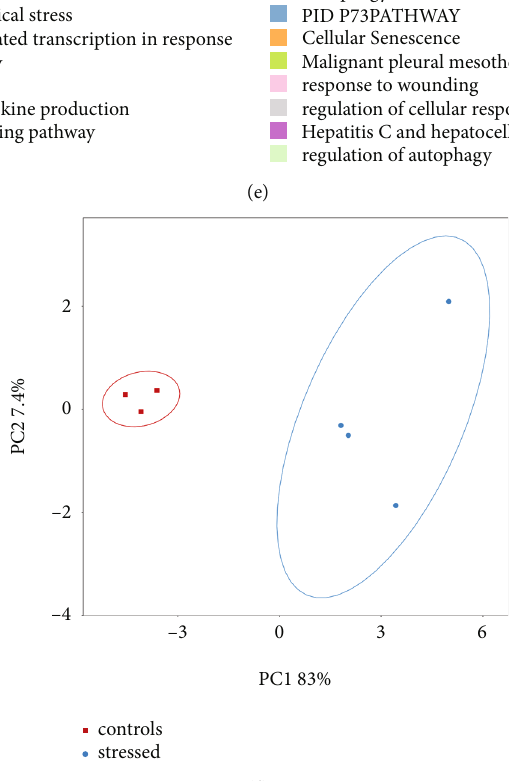
Figure 3: Core-DEGs screening, function, and pathway enrichment analysis. (a) PPI network diagram of 68 DEGs; (b) PPI network diagram of core-DEGs; (c) results of GO functional analysis of core-DEGs; (d) results of KEGG pathway enrichment of core-DEGs; (e) results of BF and pathway enrichment analysis of core-DEGs by Metascape; (f) results of PCA analysis of 19 core-DEGs in the control and stress